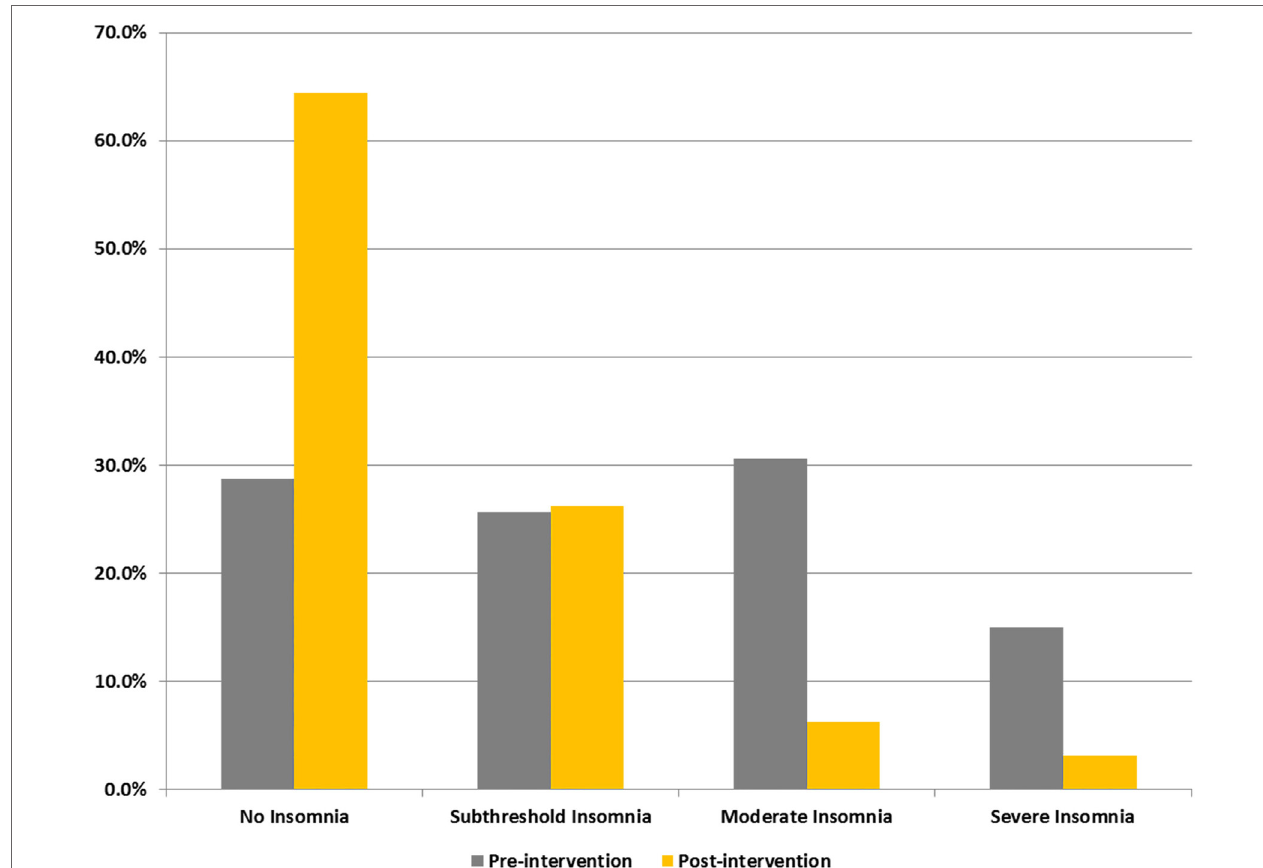
FigUre 4 | Proportions of subjects reporting different levels of insomnia (ISI) symptom severity. Categorizations are based on self-reported scores on ISI.